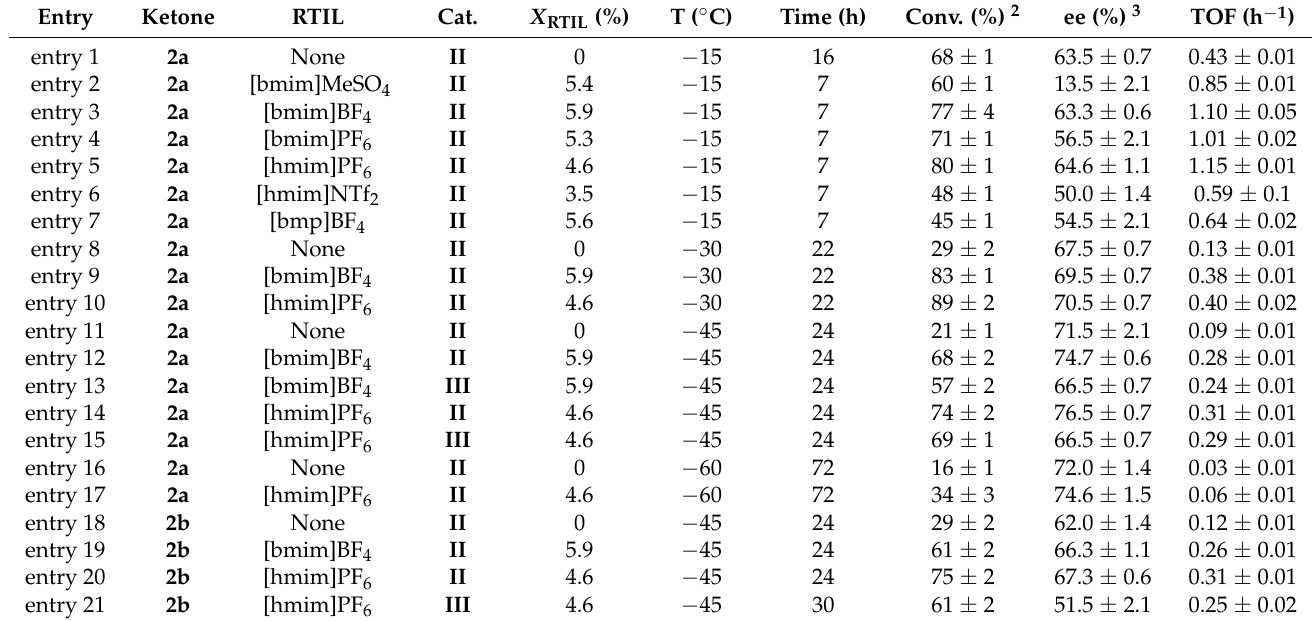
Table 1. Organocatalyzed addition of formaldehyde tert -butylhydrazone (FTBH) ( 1 ) to ethyl 2-oxo-4-phenylbutanoate ( 2a ) and ethyl 3-methyl-2-oxobutanoate ( 2b ) catalyzed by (thio)ureas II and III in toluene/RTIL (10 vol%) 1